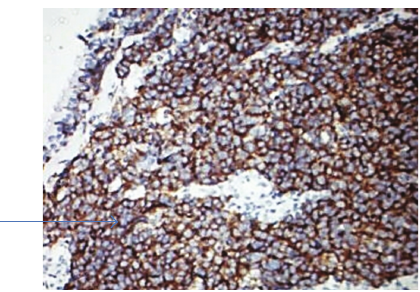
Figure 3: Neuroendocrine cells showing synaptophysin positivity (arrow). (Immunoperoxidase technique, HPR polymerase method ×